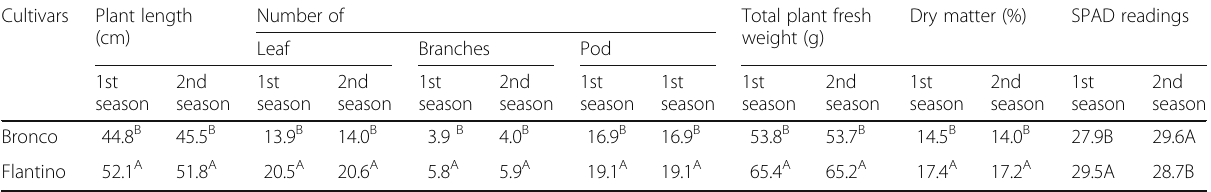
Table 2 Effect of cultivars on vegetative growth of snap bean plants during 2017 and 2018 seasons Cultivars Plant length